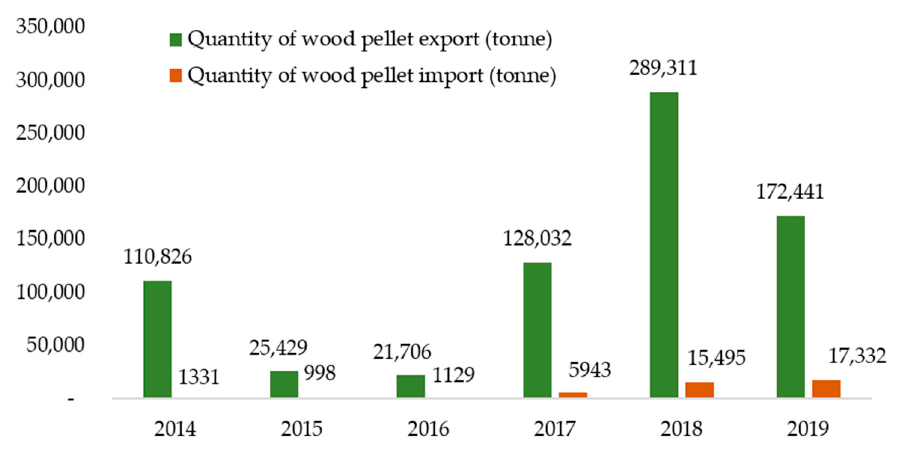
Figure 1. Quantity of wood pellet export and import of Thailand in 2014–2019 [29].